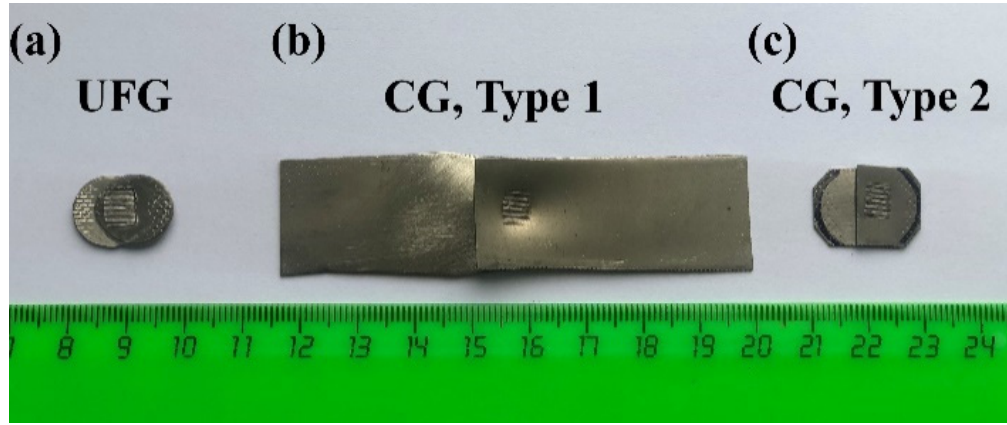
Figure 2. Joints of Ni samples with the initial ultrafine-grained structure ( a ) and Type 1 ( b ) and Type 2 ( c ) joints of samples with the initial coarse-grained structure.